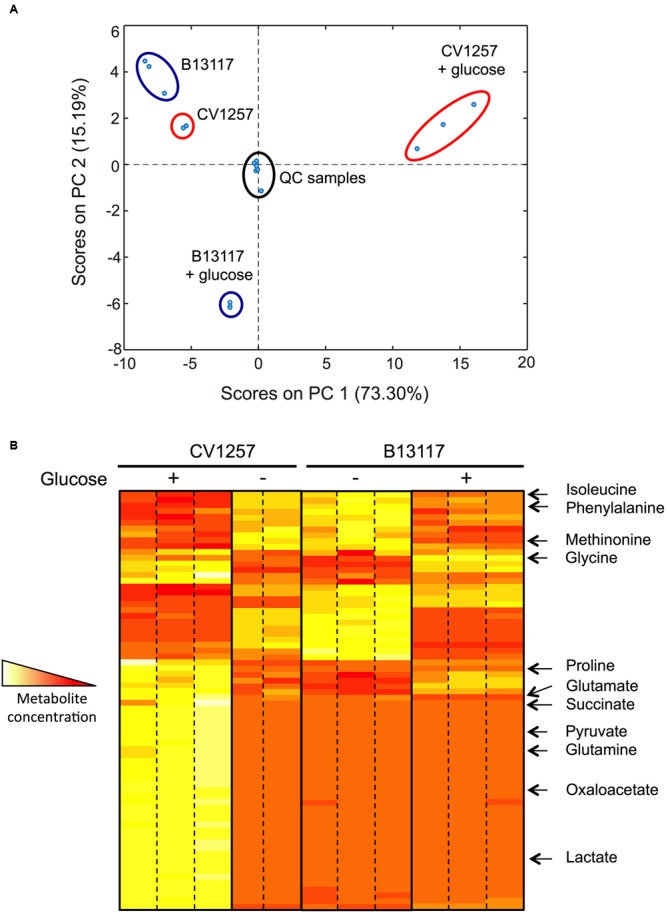
Glucose dependent changes in extracellular metabolic profiles of B13117 and CV1257 isolates. (A) Principal components analysis (PCA) plots of extracellular metabolites determined by gas chromatography–mass spectrometry (GC–MS). The PCA score plot is based on a data set consisting of three independent replicates of C. coli B13117 and CV1257 cultivated in TSB with and without glucose for 24 h at 37°C in a microaerobic atmosphere. However, only two replicates of CV1257 without glucose were used due to contamination. For quality control, mixed pooled samples (labeled QC samples) were run alongside the individual separate samples. (B) Heat map representation of the most abundant extracellular metabolites of C. coli B13117 and CV1257 samples used in (A). When cultivated without glucose the two isolates display very similar metabolite profiles (two middle panels). Upon glucose supplementation both isolates display a distinct shift in metabolic profile (two outer panels), but the two isolates respond very differently to glucose metabolism, which is seen by the highly different overall profile patterns with glucose. Compounds that could be identified by comparison to standards are shown; most compounds that could be detected were not identified. The colors represent the relative concentrations from high (white) to low (red).